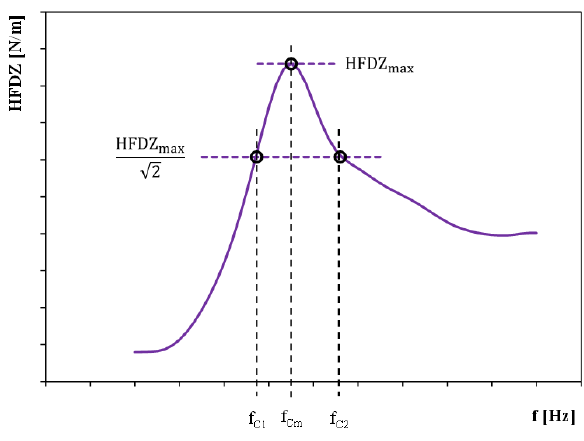
Figure 1: Illustration showing the characteristic points of the factor of gain in the force measured in the tester (HFDZ) in the half-power bandwidth